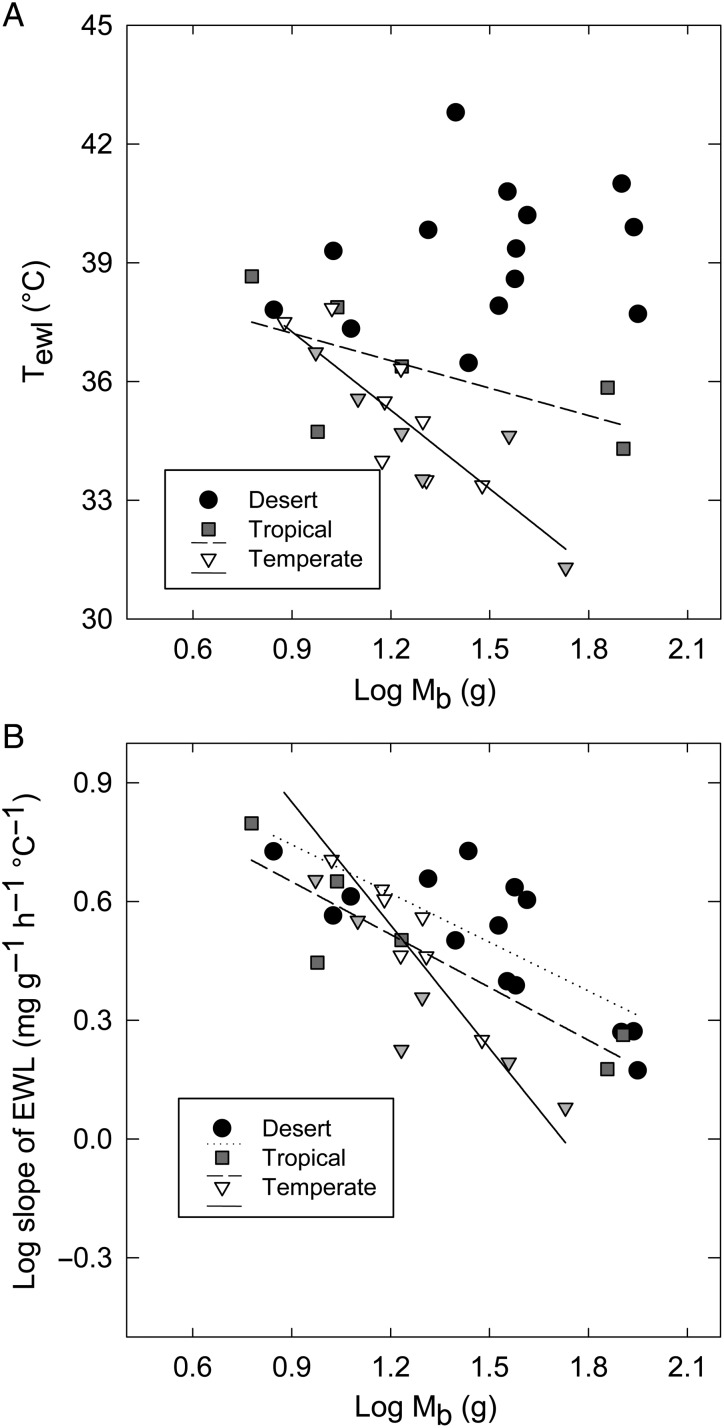
(A) The relationship between body mass (Mb; in grams) and mean EWL inflection point (Tewl; in degrees Celsius), in species from different climate zones. (B) Slope of EWL above Tewl (EWL slope; in milligrams per gram per hour per degree Celsius) as a function of body mass (Mb; in grams) in species from all three climatic zones. Statistics on conventional and phylogenetic least-squares analyses are presented in the main text. Trend lines represent significant relationships. Symbols represent the following: desert species are represented by black circles, tropical species by grey squares, and temperate species by triangles. Fynbos endemics within the temperate group are illustrated by the grey triangles.